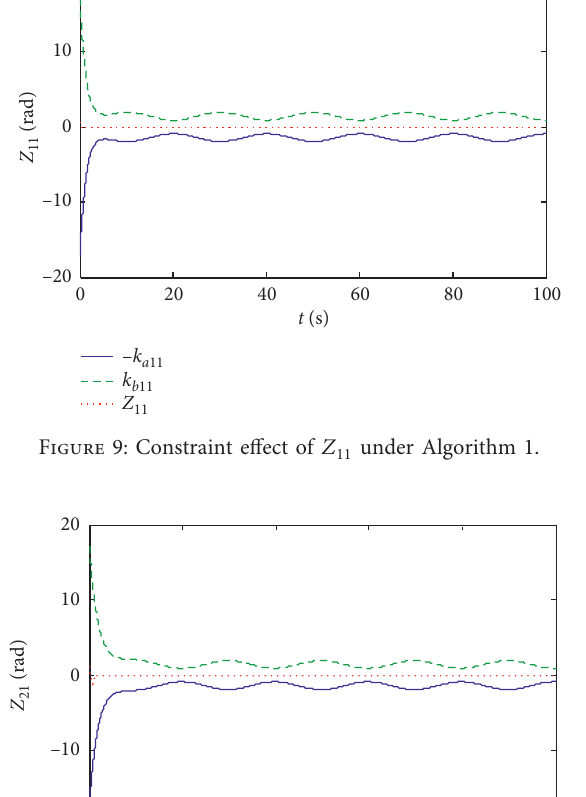
under Algorithm 1. 21